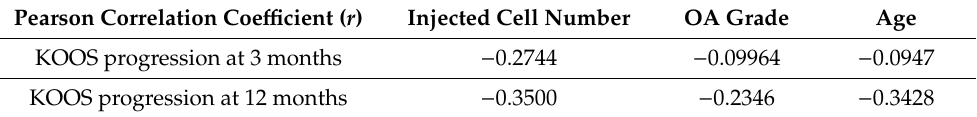
Table 3. Pearson correlation coe ffi cient of age, BMI, injected cell number, and grade of osteoarthritis in relation to the progression of the KOOS scores at the respective follow-up time points of 1, 3, 6, and 12 months after the treatment of knee osteoarthritis with freshly isolated SVF from the adipose tissue. Pearson Correlation Coe ffi cient ( r ) Injected Cell Number OA Grade Age KOOS progression at 3 months − 0.2744 − 0.09964 − 0.0947 KOOS progression at 12 months − 0.3500 − 0.2346 −